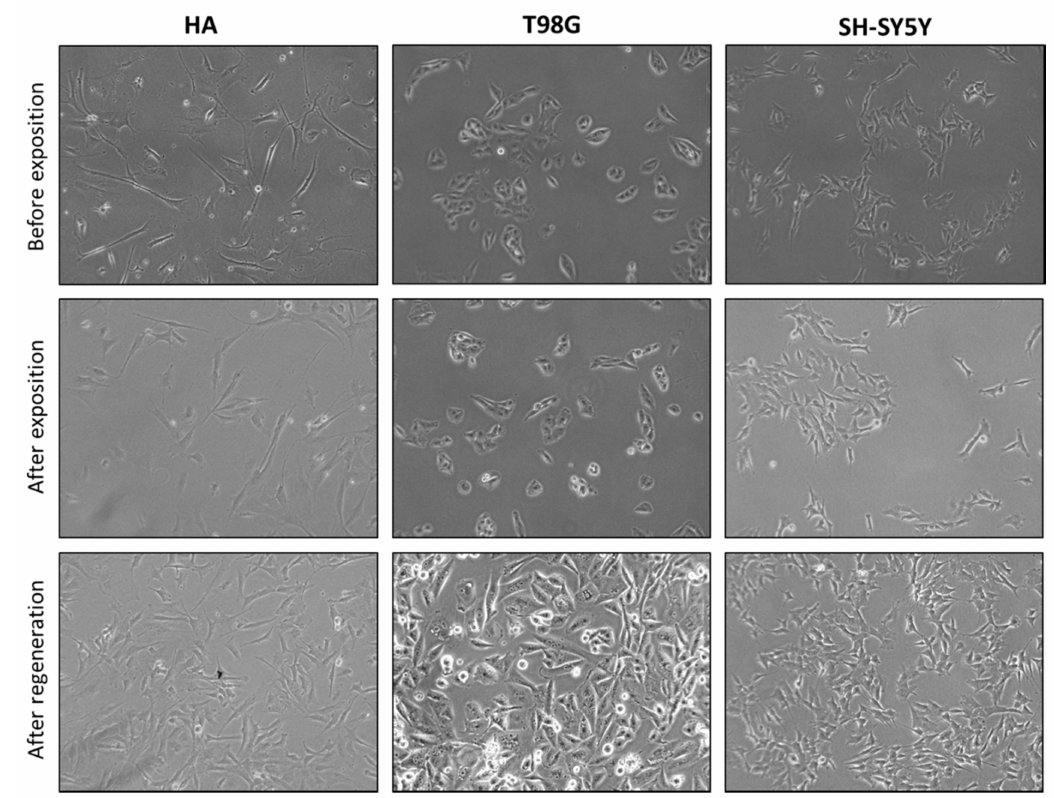
Figure 10. Cell morphology of human neural cells (HA, T98G, SH-SY5Y) analyzed by light microscopy. Cells before EMF exposure (first row), cells directly after exposure (87 kHz EMF for 30 min; second row) and cells after 44 h of regeneration in standard conditions (third row). Representative photomicrographs were taken at phase contrast at magnification 100 × .